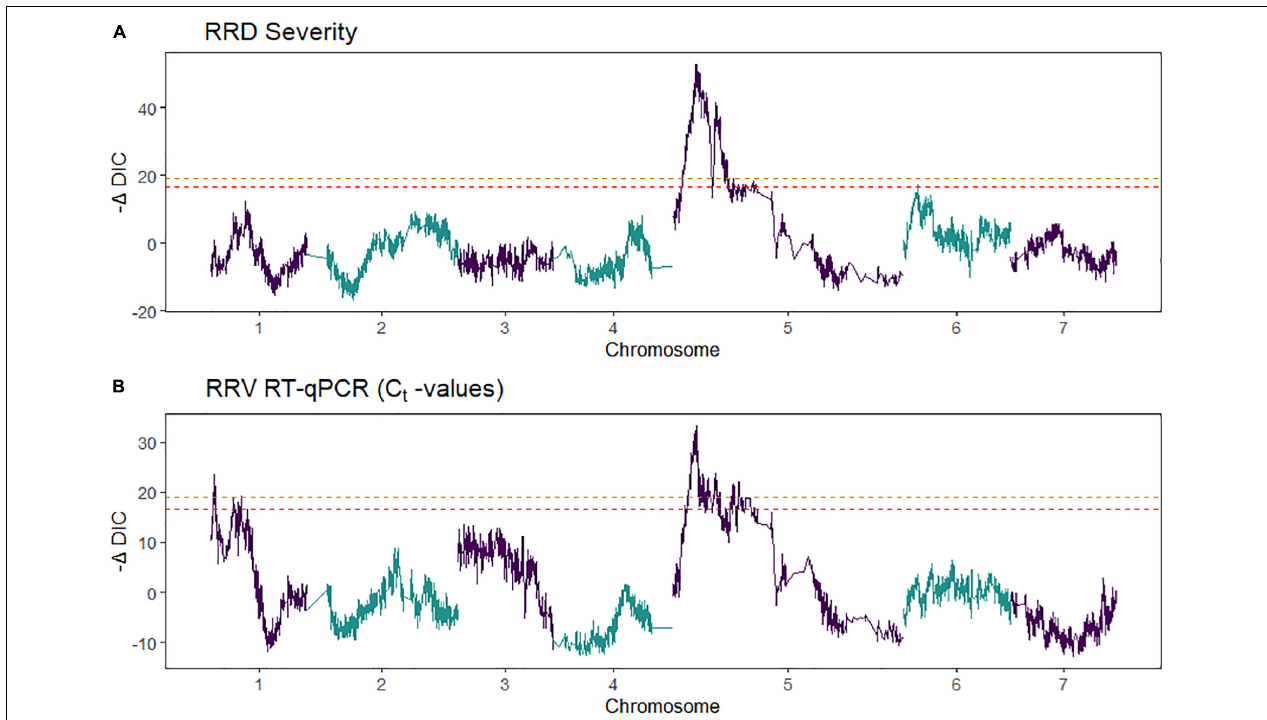
FIGURE 6 | Quantitative trait locus scans from two tetraploid garden rose interconnected populations for (A) rose rosette disease (RRD) severity and (B) C t values from R-software package diaQTL. On the x -axis is the genome position and on the y -axis is the relative strength of the QTL measured – (cid:49) DIC, the test statistic used in detecting QTL in diaQTL. The peaks observed in the – (cid:49) DIC profile are similar to other test statistics used to plot QTL profiles. The gold-colored line and red-colored line are alpha = 0.05 and 0.10 genome-wide significance,